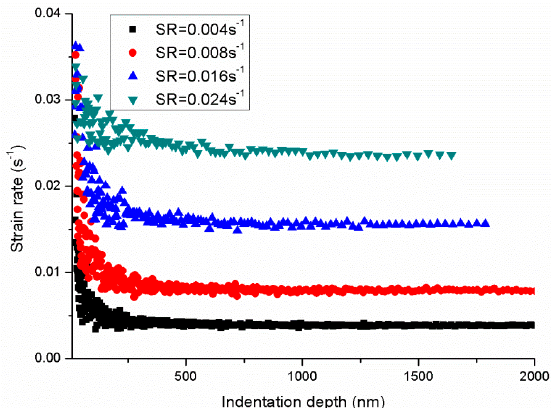
Figure 5. Variation of the indentation strain rate vs depth of PMMA at different indentation strain rates.